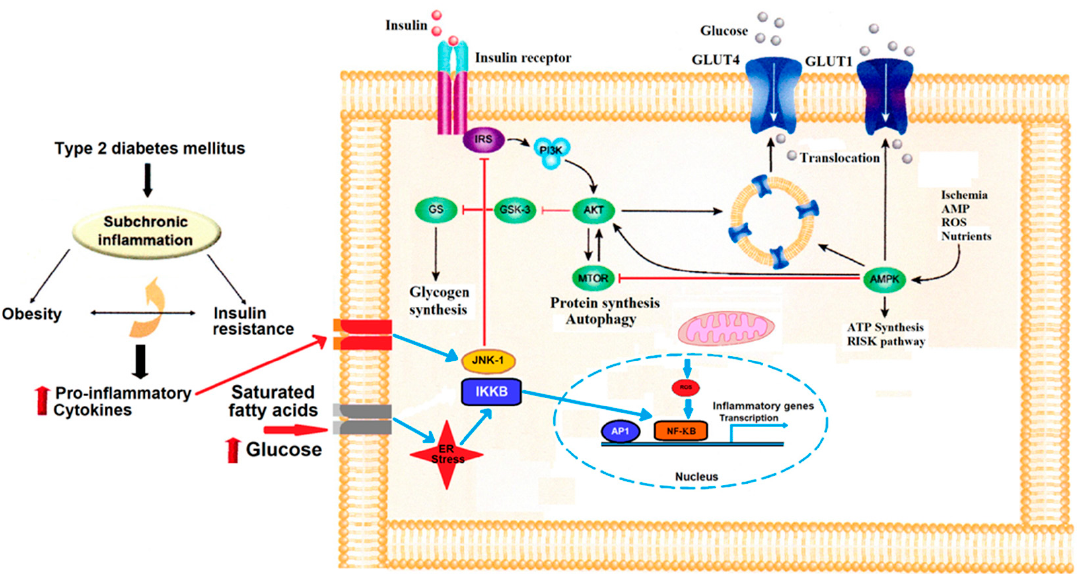
Figure 2. The insulin signaling pathway and the molecular mechanism of insulin resistance due to inflammation. Binding of insulin stimulates the association of its receptor with downstream medi- ators, including insulin receptor substrate-1 (IRS-1) and PI3K. The PI3K/AKT/GSK-3 β signaling pathway is involved in insulin signaling transduction, and GSK3 β is regulated and controlled by insulin in this signaling pathway, which is related to glycogen synthesis regulation. Through specific receptors, hyperglycemia, fatty acids, and pro-inflammatory cytokines, as well as ROS, activate JNK and IKKB favoring NF- κ B translocation into the nucleus and, therefore, transcription of inflammatory genes.